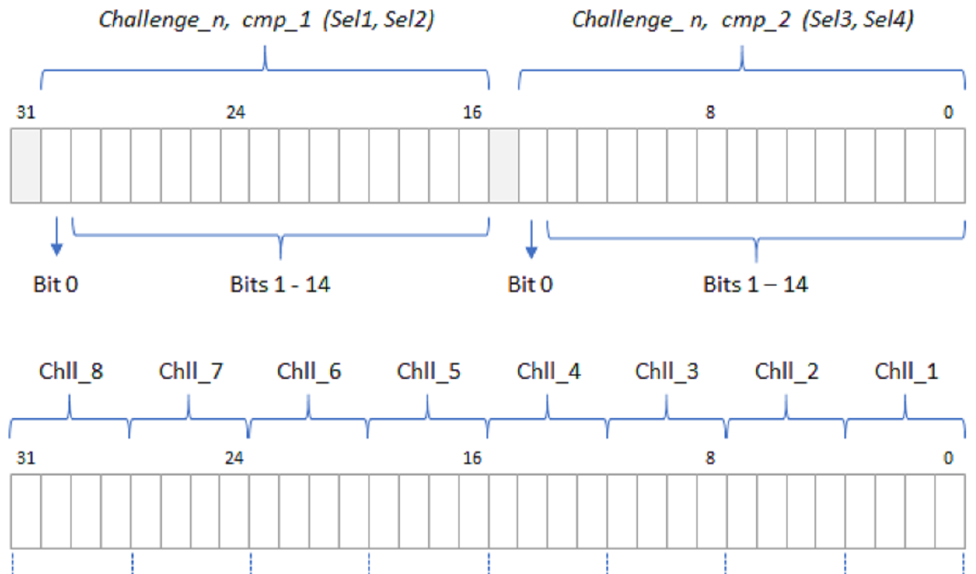
Figure 3. PUF/TRNG output register in characterization ( upper ) and operation ( lower ) mode when using 14-bit counters and a 32-bit interconnect